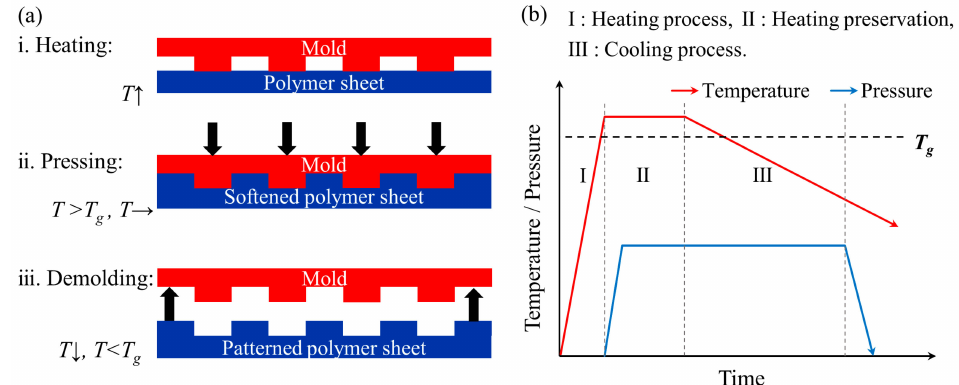
Figure 3. ( a ) Schematic illustrations of thermal nanoimprint process on polymer sheet; and ( b ) sequence of heating and pressing during the thermal nanoimprint process.